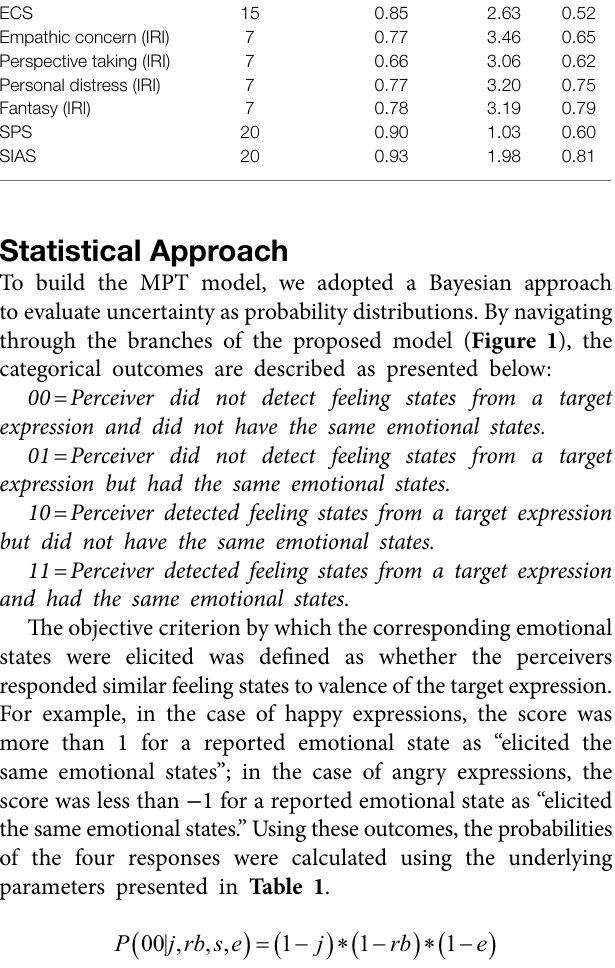
TABLE 2 | Internal consistency (Cronbach’s Alpha) and descriptive statistics for questionnaire responses. Subscale No. of